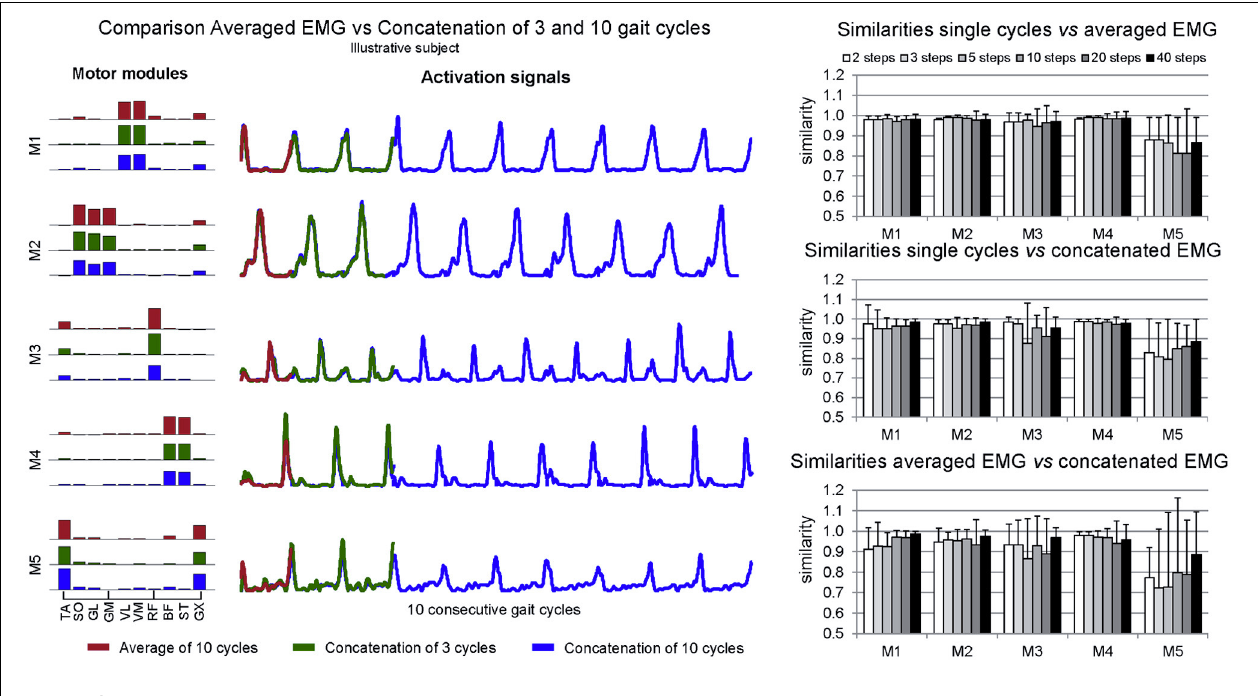
FIGURE 4 | Illustrative comparison of averaged EMG and concatenated EMG from a single subject ( left ). On the right, mean ± SD similarities between muscle weightings extracted from single trials vs. averaged EMG